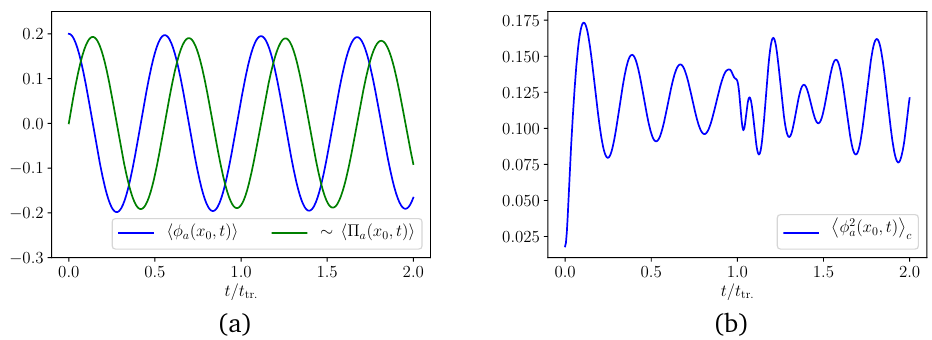
Figure 1: (a) Josephson oscillations of relative density (arbitrary units) and phase = L / 2. (b) initial growth and oscillations of the (radians) at the centre of the gas, x 0 variance of the relative phase. The initial phase and density profiles are chosen ac- cording to Eqs. (80,81) and coupling between the sectors is absent in these pictures, meaning σ = 0.